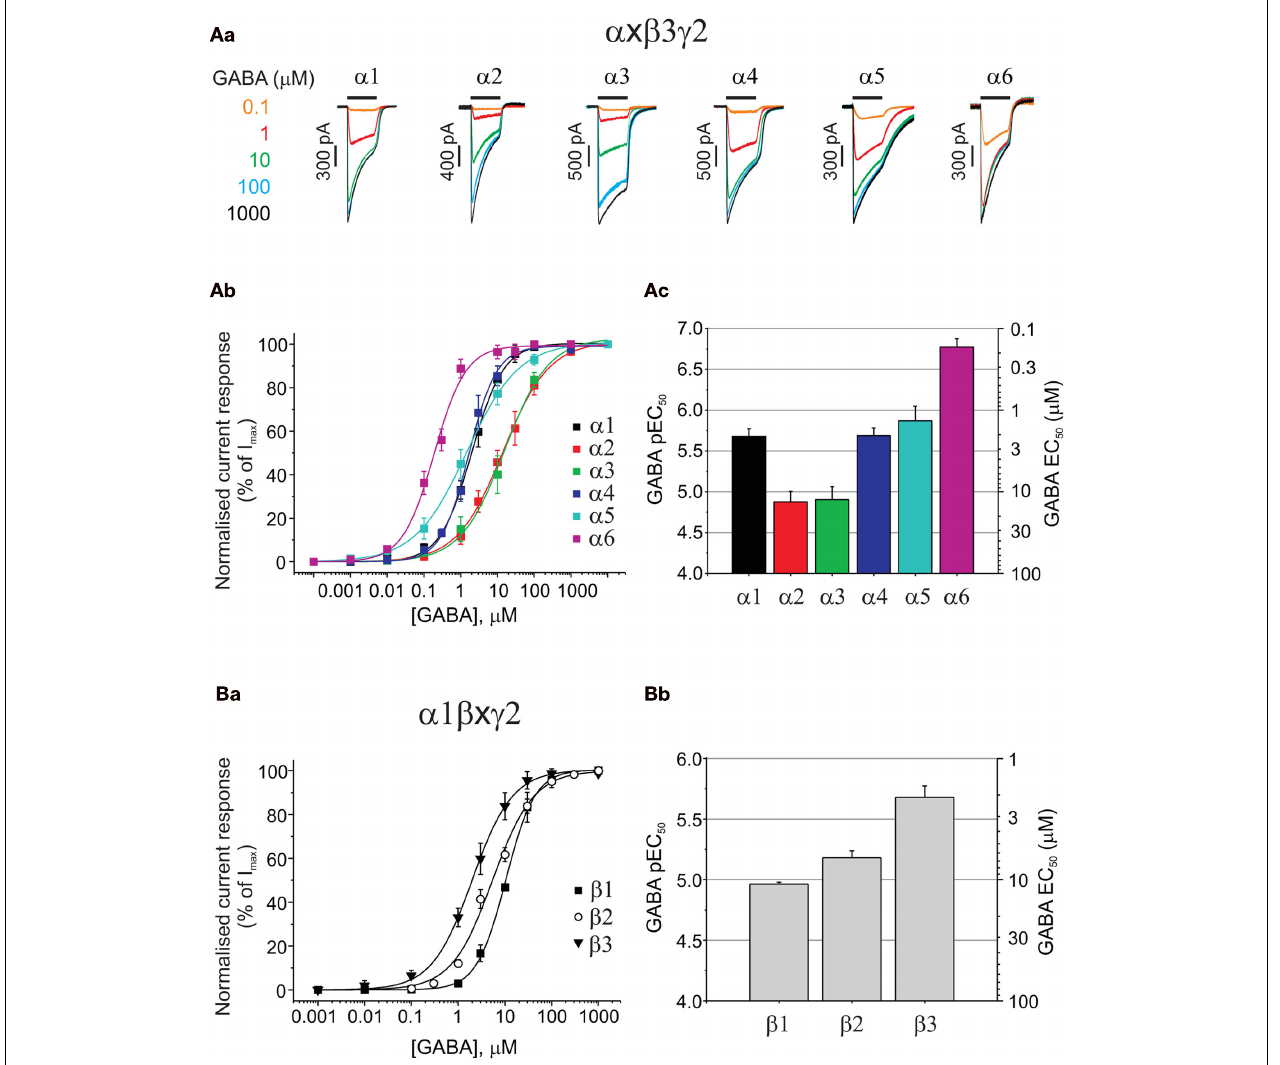
α 1–6 β 3 γ 2. Points are mean ± SEM (5–7 cells). (Ac) Bar chart of mean GABA pEC 50 values ± SEM (left ordinate) and equivalent EC 50 values (right ordinate) for α 1–6 β 3 γ 2 receptors. (Ba) Displays GABA concentration response curves for α 1 β 1–3 γ 2 receptors ( n = 5–34 cells), and (Bb) depicts the pEC 50 values (mean ± SEM) and the equivalent EC 50 values